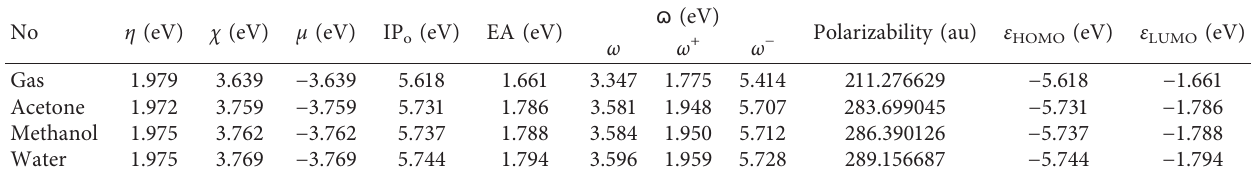
Table 2: Chemical reactivity indices obtained using the DFTmethod in gas, acetone methanol, and water media at B3LYP/6-311++G(d, p) level of